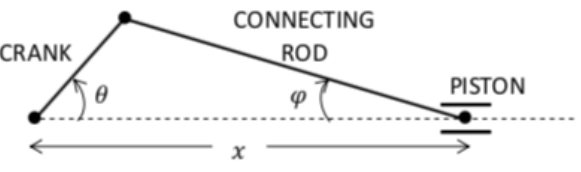
Figure 8. Crank/connecting rod system.